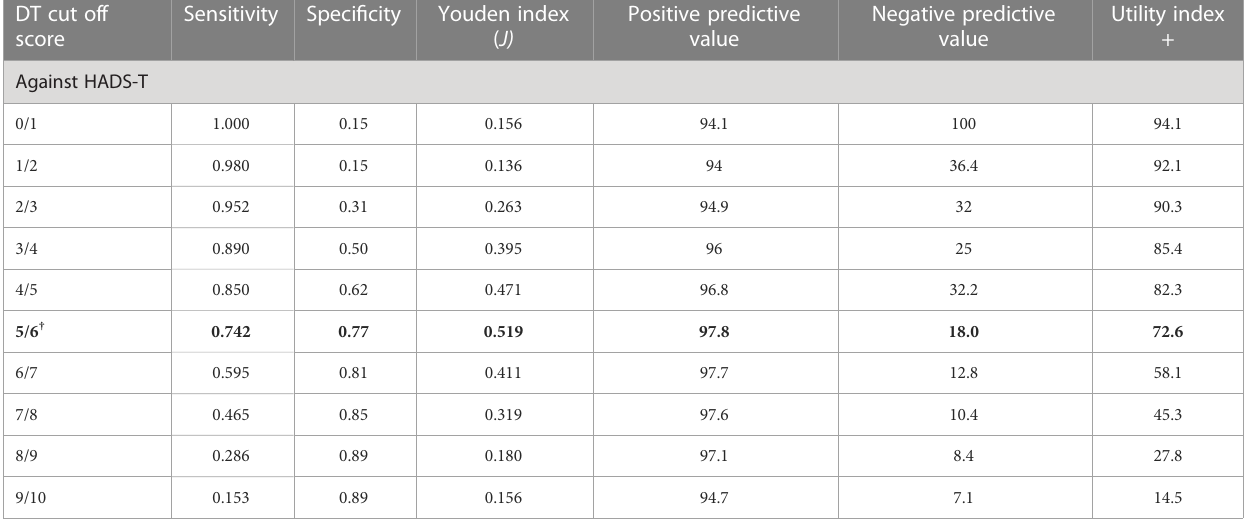
TABLE 2 Accuracy measures for DT scores according to